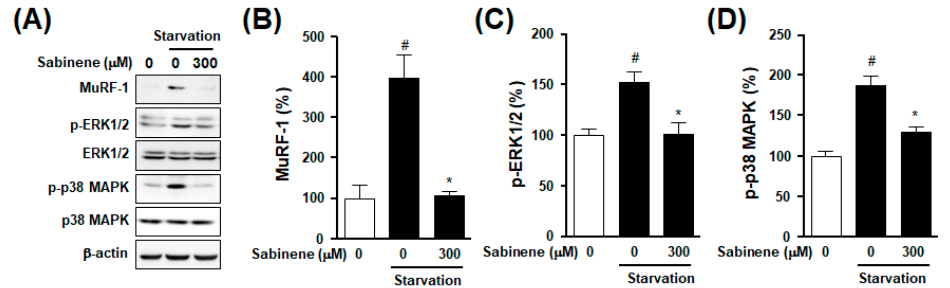
Figure 4. Effects of sabinene on muscle atrophy-related signaling proteins in starved myotubes. ( A ) Effects of sabinene on muscle atrophy-related signaling proteins. L6 myotubes were incubated with serum-free DMEM in the absence or presence of sabinene (300 µ M) for 18 h. Myotube lysates were immunoblotted with indicated antibodies. ( B – D ) Statistical graphs obtained from panel (A).